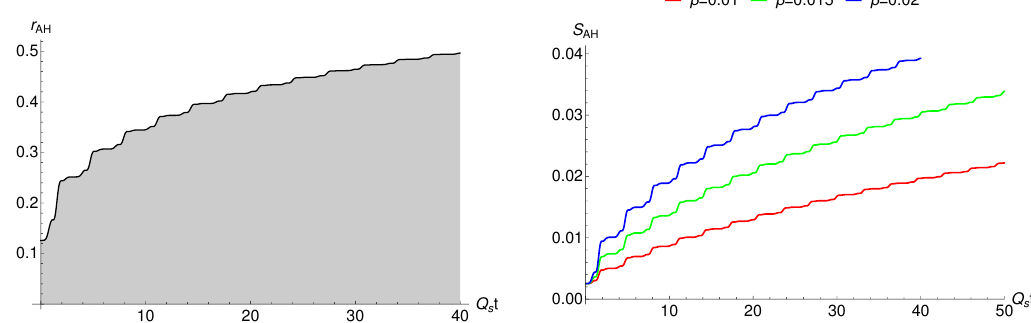
Figure 5 . Left: radial position of the apparent horizon for (cid:12) = 0 : 02. The gray region indicates the interior of the black hole. Right: entropy in the holographic sector computed from the corresponding areas of the apparent